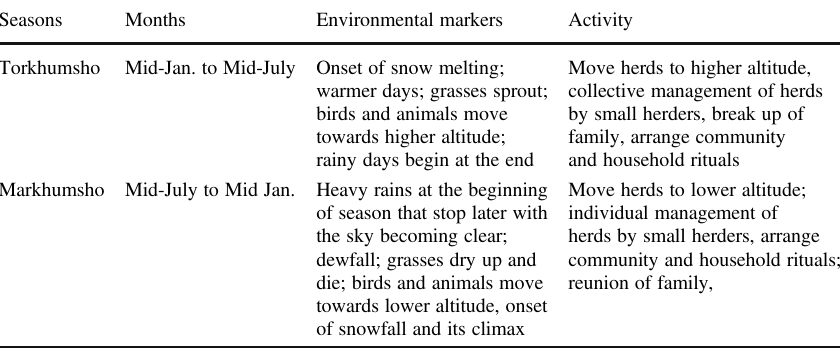
Table 2 The nomenclature of seasons and the relevant social activities of herders Seasons Months Environmental markers Activity Torkhumsho Mid-Jan. to Mid-July Onset of snow melting;